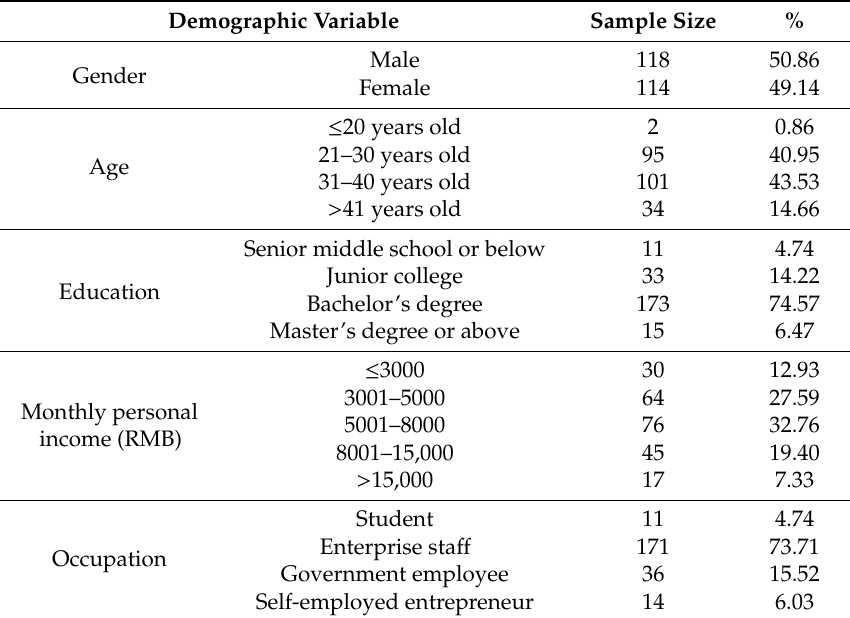
Table 2. Descriptive statistics of respondent